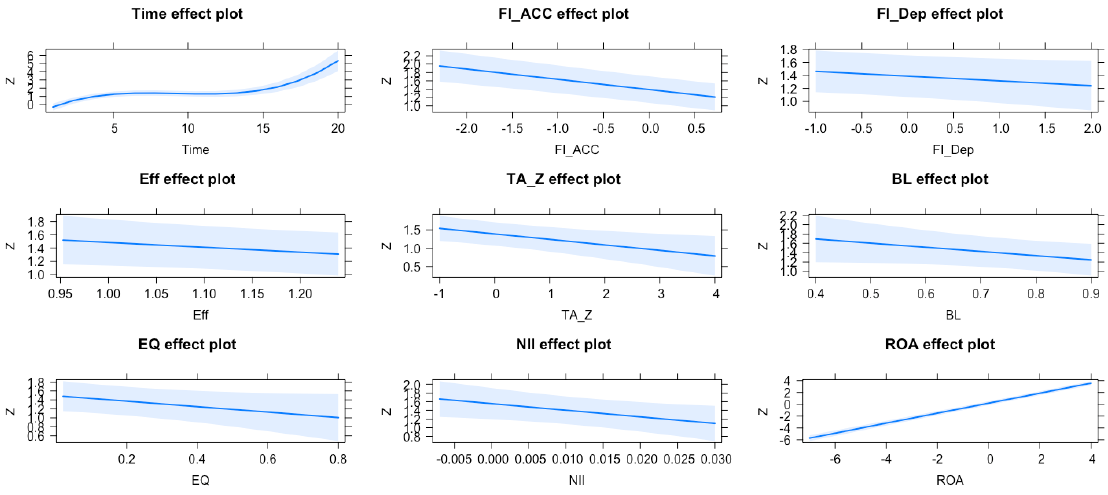
Figure 2. Significant factor effect plots.